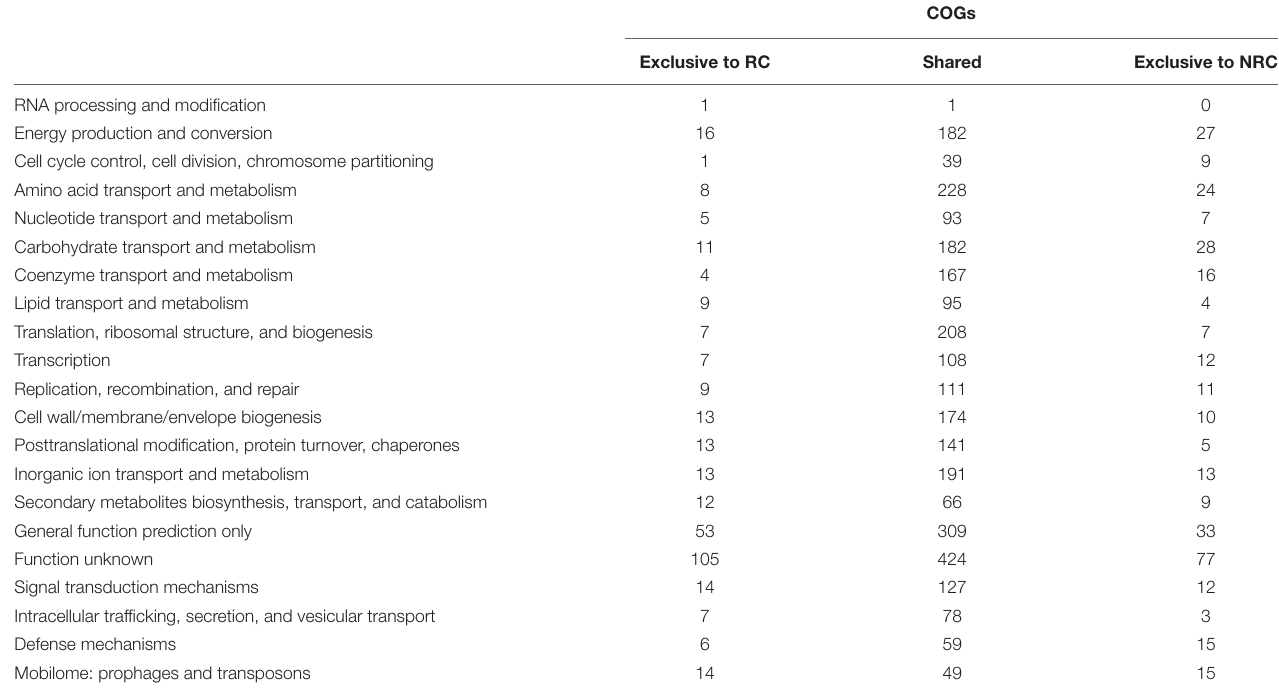
TABLE 3 | Functional overlap and exclusiveness of COGs between robust and non-robust